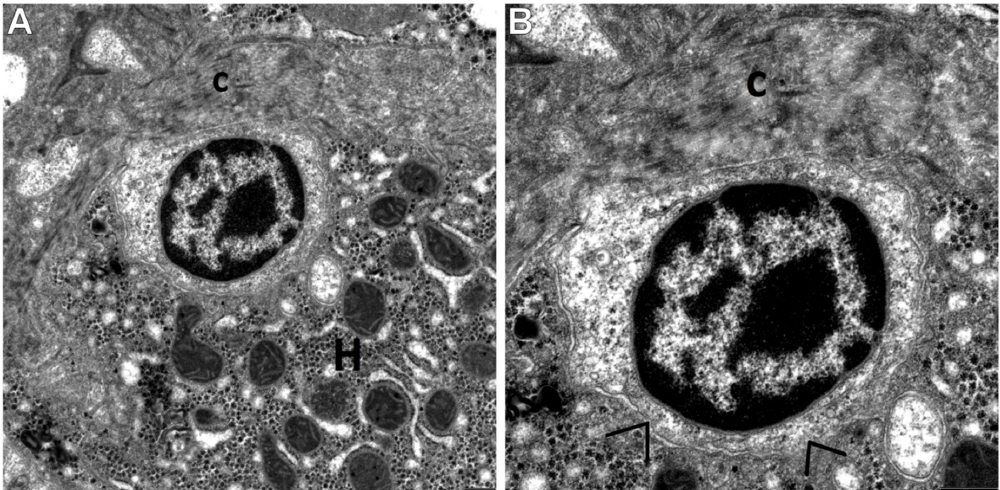
Figure 2. Electron micrographs showing a centrally located, very primitive-looking undifferentiated hepatic progenitor cell (UPC) of type I in a liver biopsy obtained from a child with AIH. ( A ) The UPC does not show any signs of differentiation. It is very small in size, oval in shape, has scant cytoplasm, markedly high nucleus/cytoplasm ratio, and undifferentiated cytoplasmic structures. The nucleus of this cell is large, round, and contains dense heterochromatin clumped under the nuclear envelope and well-pronounced small nuclear bodies surrounded by the euchromatin band. H—hepatocyte. A thick bundle of collagen fibers (c) surrounds the progenitor cell from the top and adheres closely to it. Scale bar: 1 µm. ( B ) Higher magnification of the UPC well demonstrates an almost complete lack of cell organelles within a relatively light cytoplasm with microgranular structure; above the cell, adjacent collagen fibers (c) are well seen to accumulate. Between the UPC and the adjacent mature hepatocyte, point desmosomes (intercellular junctions) (>) are present. Scale bar: 0.5 µm.